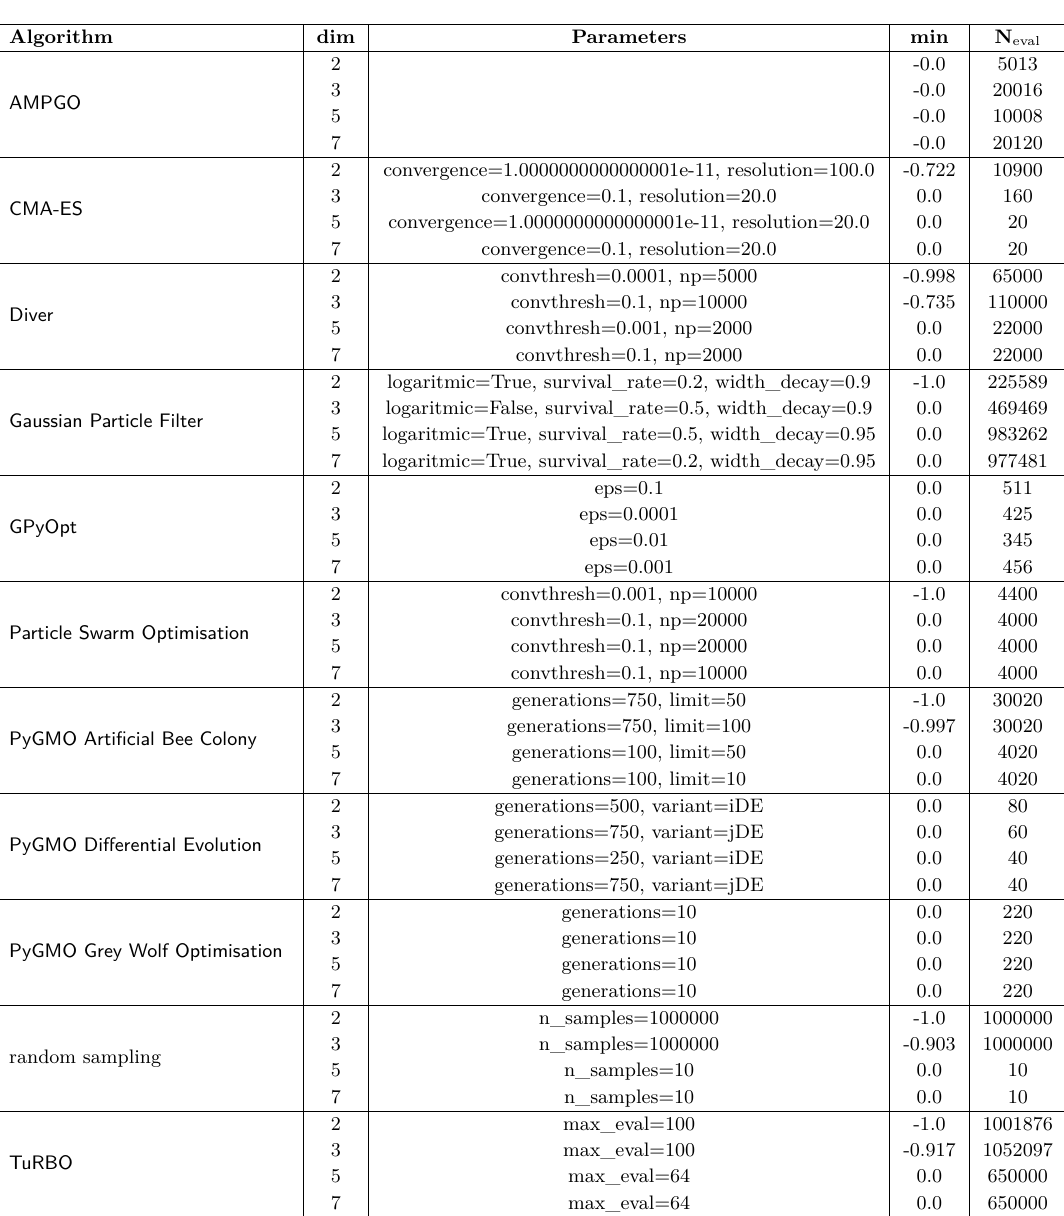
Table 3. Best obtained result for Analytic Function 1 (equation (3.1)). The ‘best’ result is the result with the lowest found function value. If multiple samples found the same value, the result with the fewest number of needed function evaluations is